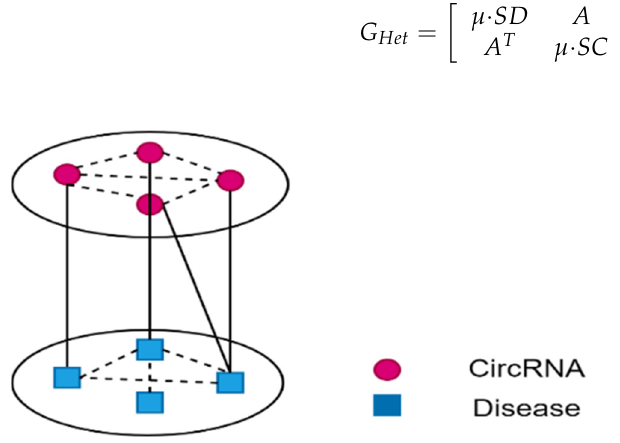
Figure 1. Illustration of the heterogeneous network.